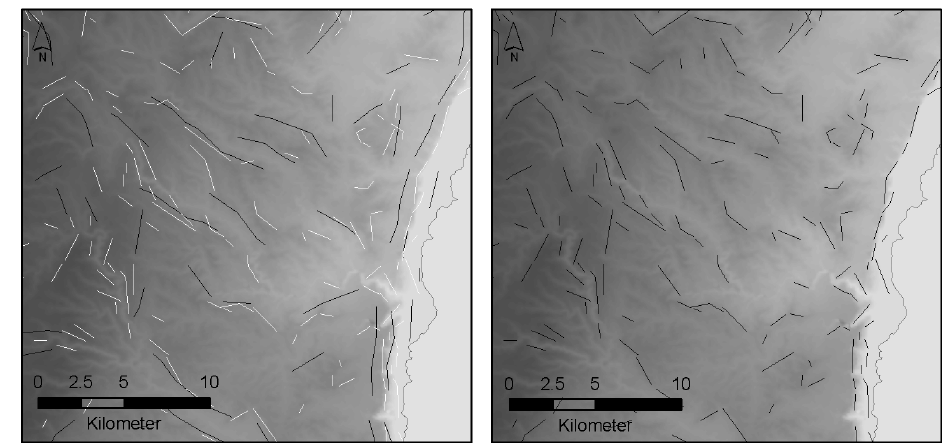
Fig. 3. Left figure shows a subset of the comparison of lineaments resulting from object-based classification (white lines) to lineaments obtained from PCI LINE algorithm (black lines) – right figure shows the same subset after singularization of identical results with respect to the object based